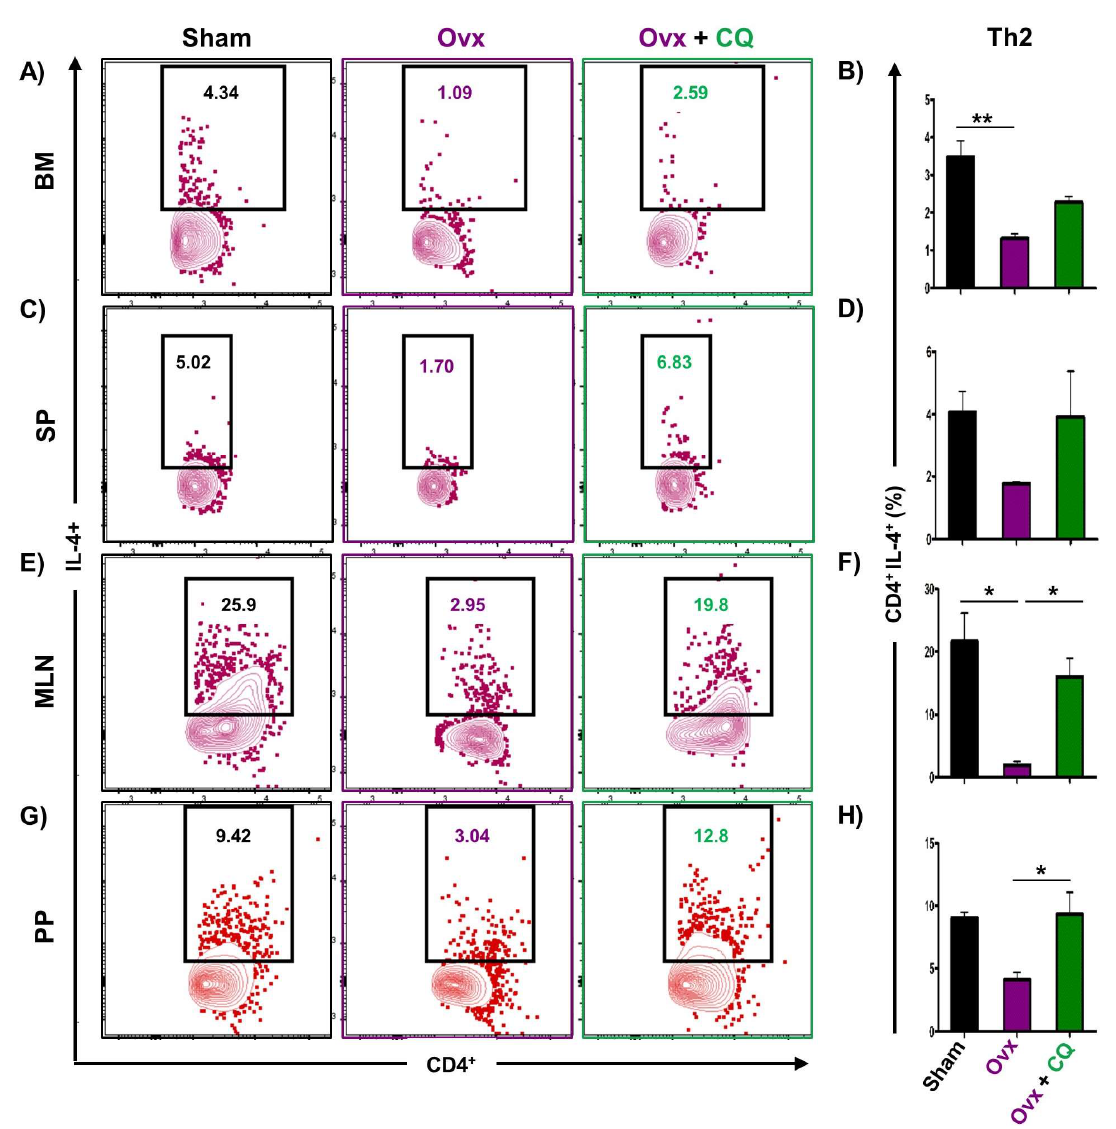
Figure 6. CQ administration enhances Th2 cells in Ovx mice: Immune cells harvested from the lymphoid organs of all the groups were analyzed by flow cytometry for the percentage of CD4 + IL-4 + Th2 immune cells. ( A ) Contour plot representing the percentage of CD4 + IL-4 + Th2 in BM. ( B ) Bar graphs representing the percentage of CD4 + IL-4 + Th2 in BM. ( C ) Contour plot representing the percentage of CD4 + IL-4 + Th2 in SP. ( D ) Bar graphs representing the percentage of CD4 + IL-4 + Th2 in SP. ( E ) Contour plot representing the percentage of CD4 + IL-4 + Th2 in MLN. ( F ) Bar graphs representing the percentage of CD4 + IL-4 + Th2 in MLN. ( G ) Contour plot representing the percentage of CD4 + IL-4 + Th2 in PP. ( H ) Bar graphs representing the percentage of CD4 + IL-4 + Th2 in PP. ANOVA was used to analyse the results, and then unpaired Student t-tests were used to compare the indicated groups. Values are expressed as mean ± SEM, and equivalent outcomes were observed in two independent experiments. For the indicated groups, p 0.05 (* p ≤ 0.05, ** p ≤ 0.01) was used as the cutoff for statistical significance.